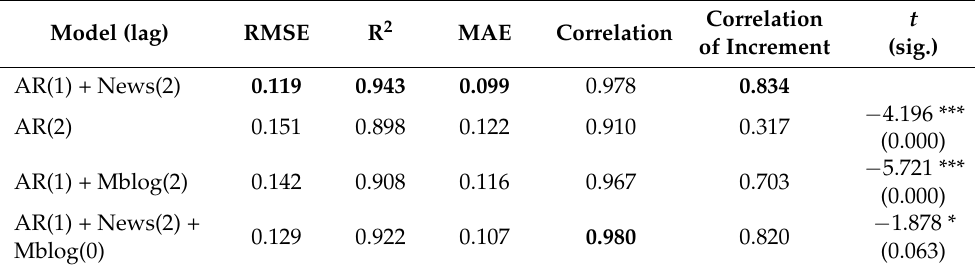
Table 2. Comparison of different models for the forecasting of influenza epidemics: north of mainland China. Model (lag) RMSE R 2 MAE Correlation